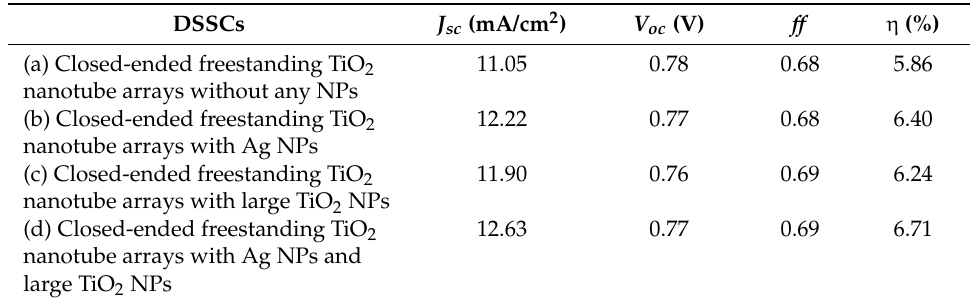
Table 1. Photovoltaic properties of dye-sensitized solar cells (DSSCs) based on closed-ended freestanding TiO 2 nanotube arrays.